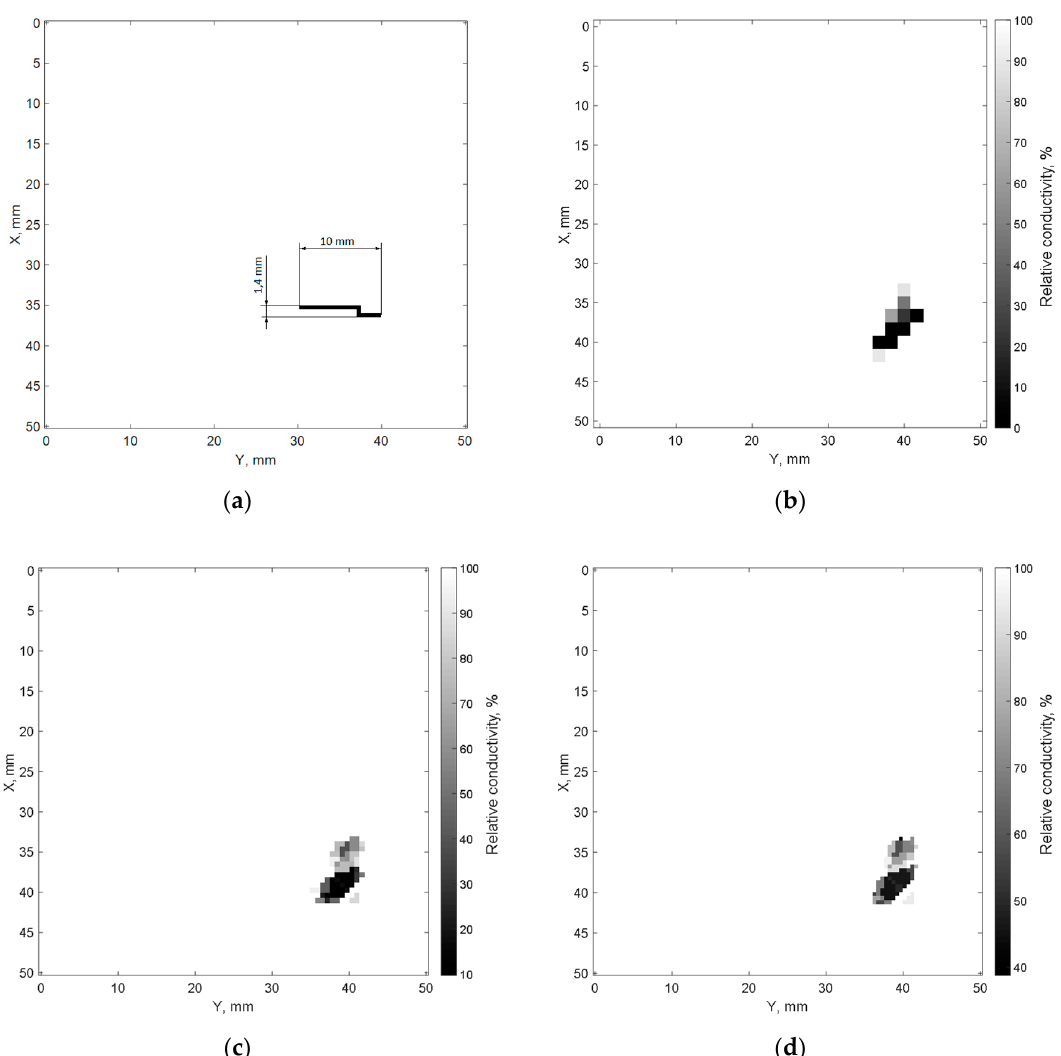
Figure 4. Results of imitative modeling of the process of the crack ( a ) detection obtained at a specific conductivity of the initial sensor film at 2.33 × 10 6 S/m, for the 12 contacts, with the digital filter parameters γ = 1 × 10 4 and K F = 0.03 for the coordinate grids with a node number of 31 × 31 ( b ), 79 × 79 ( c ), 103 × 103 ( d ).